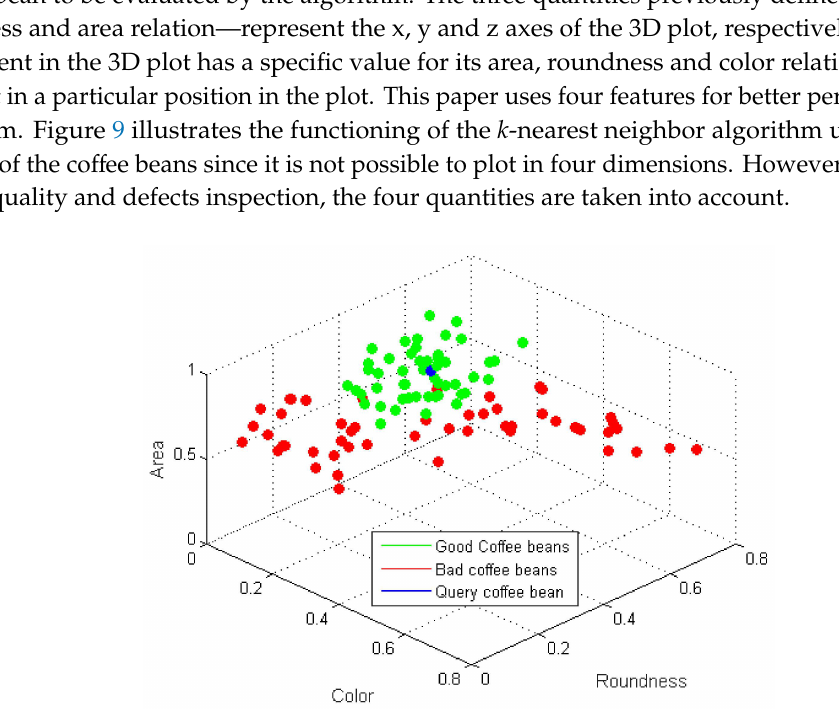
Figure 9. 3D plot for the k -nearest neighbor algorithm using the training